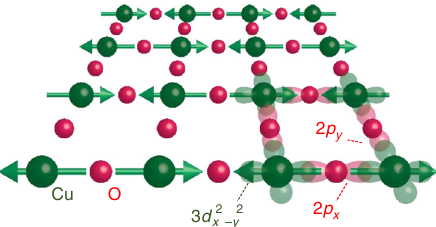
Fig. 1 Schematic of the CuO 2 ab plane. The electronic spin arrangement is illustrated with green arrows. The translucent lobes represent the electronic orbitals that form the two-dimensional electronic state